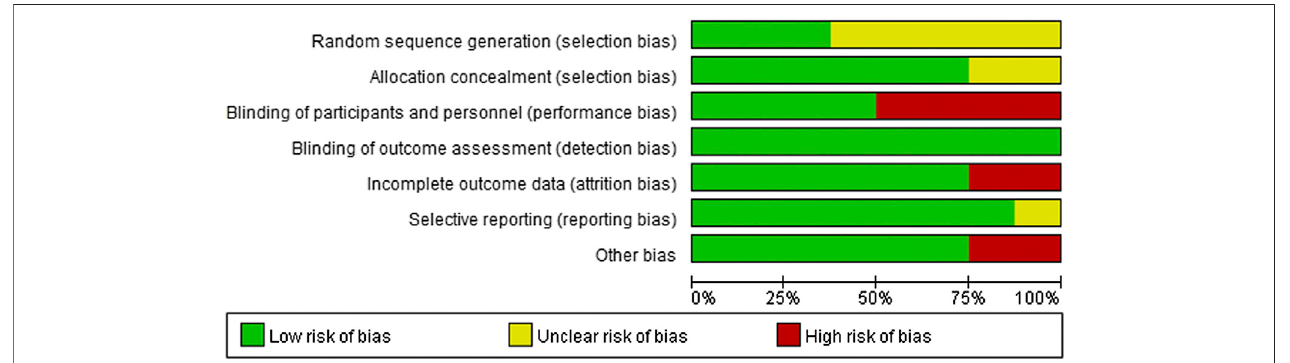
FIGURE 2 | Risk-of-bias summary of included randomized trials using the Cochrane risk-of-bias tool.